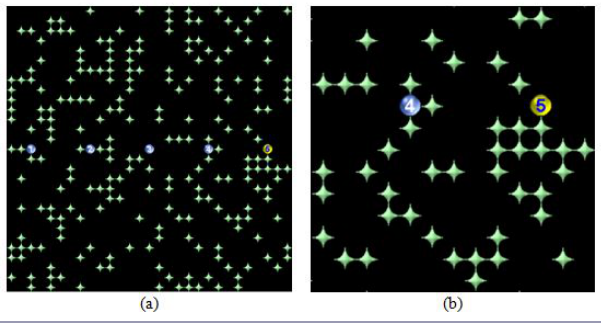
Fig. 5 . The foraging game is a spatially explicit experimental